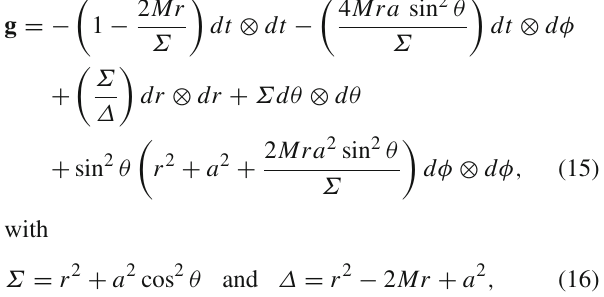
Fig. 11 Graphic representation of the deflection in the path of the pho- tons in the presence of a compact object. Due to the strong gravitational field, some photons emitted from a quadrant can be detected in the image plane as if they had a different point of origin